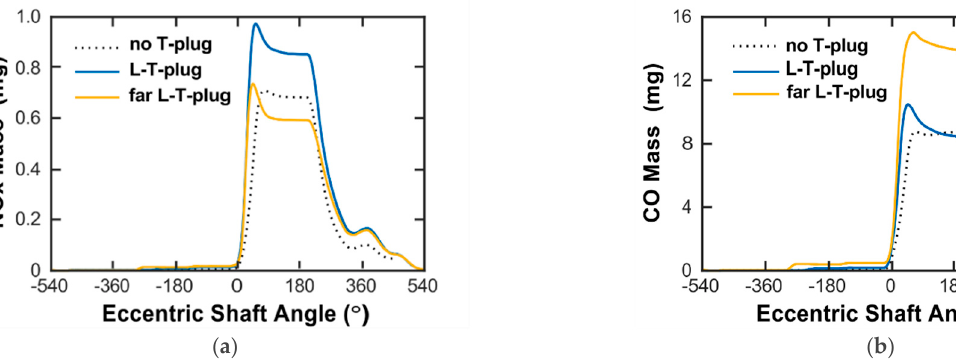
Figure 16. Simulated total mass of ( a ) NOx and ( b ) CO in the working chamber of L-slot case without T-plug, with close T-plug, and far T-plug.